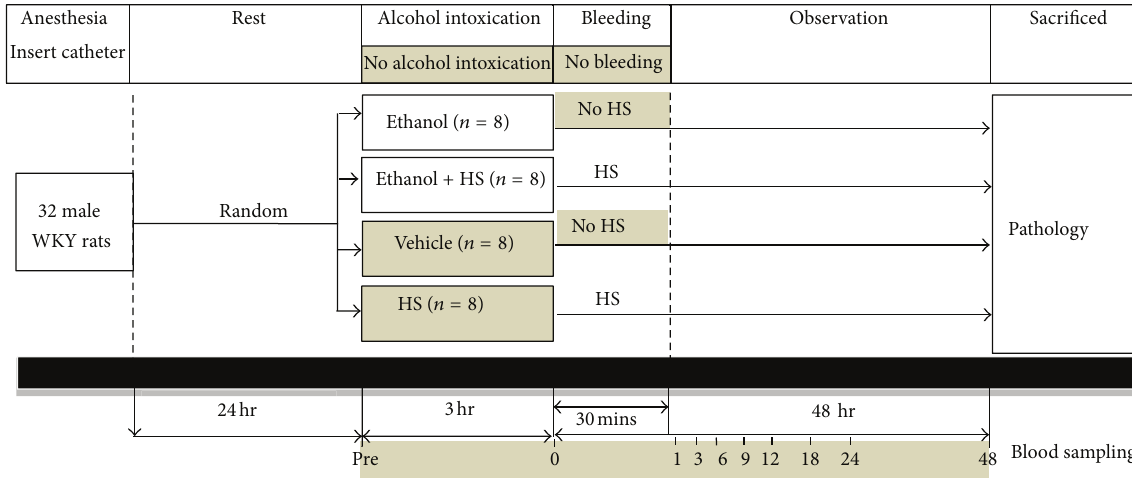
Figure 1: Timeline of hemorrhage and blood sampling protocols for this